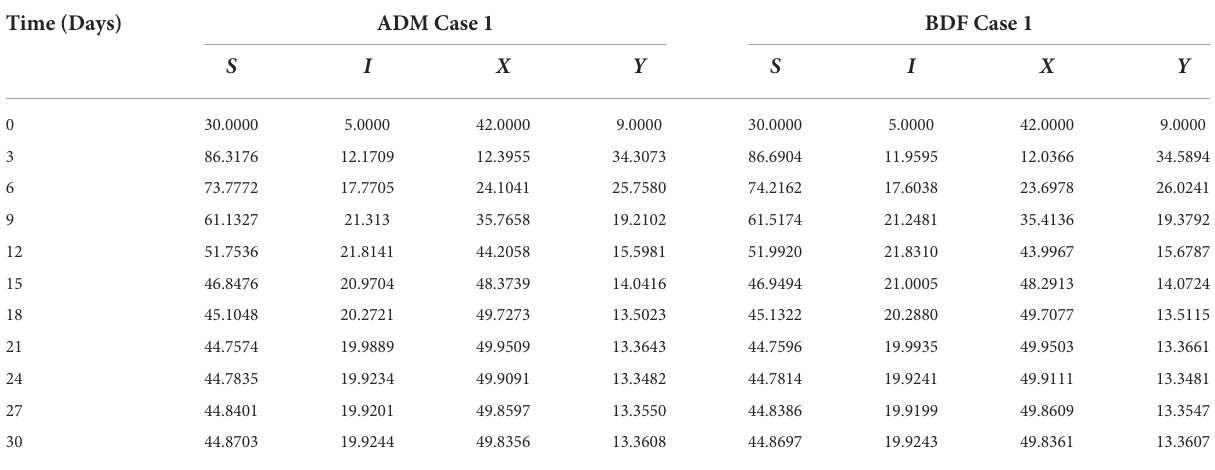
TABLE 8 Numerical outcomes of nonlinear PVPMV model B2 for case-1 of scenario